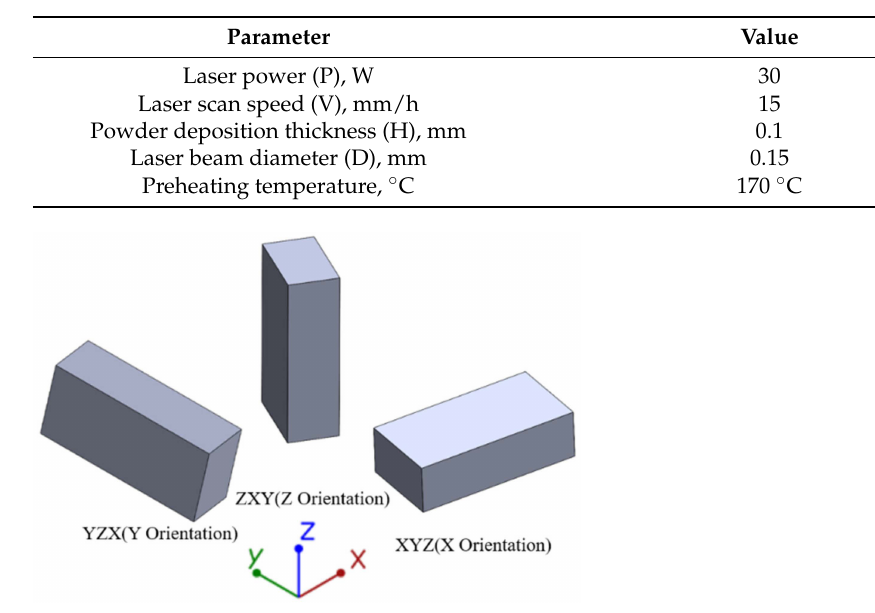
Table 2. Values of process parameters for printing equipment.